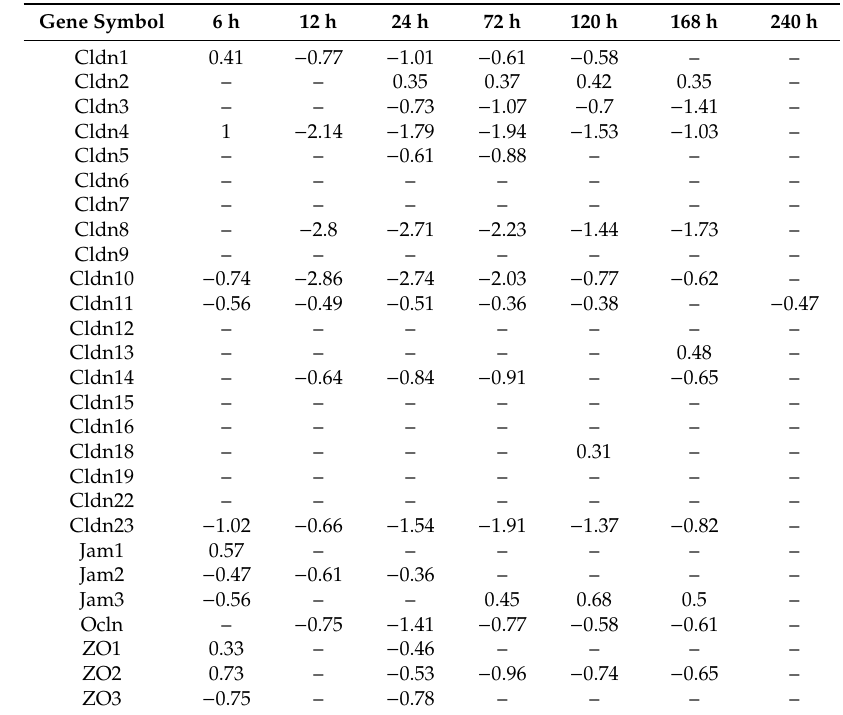
Table 1. LogFC of di ff erentially expressed genes over time in skin 1 .